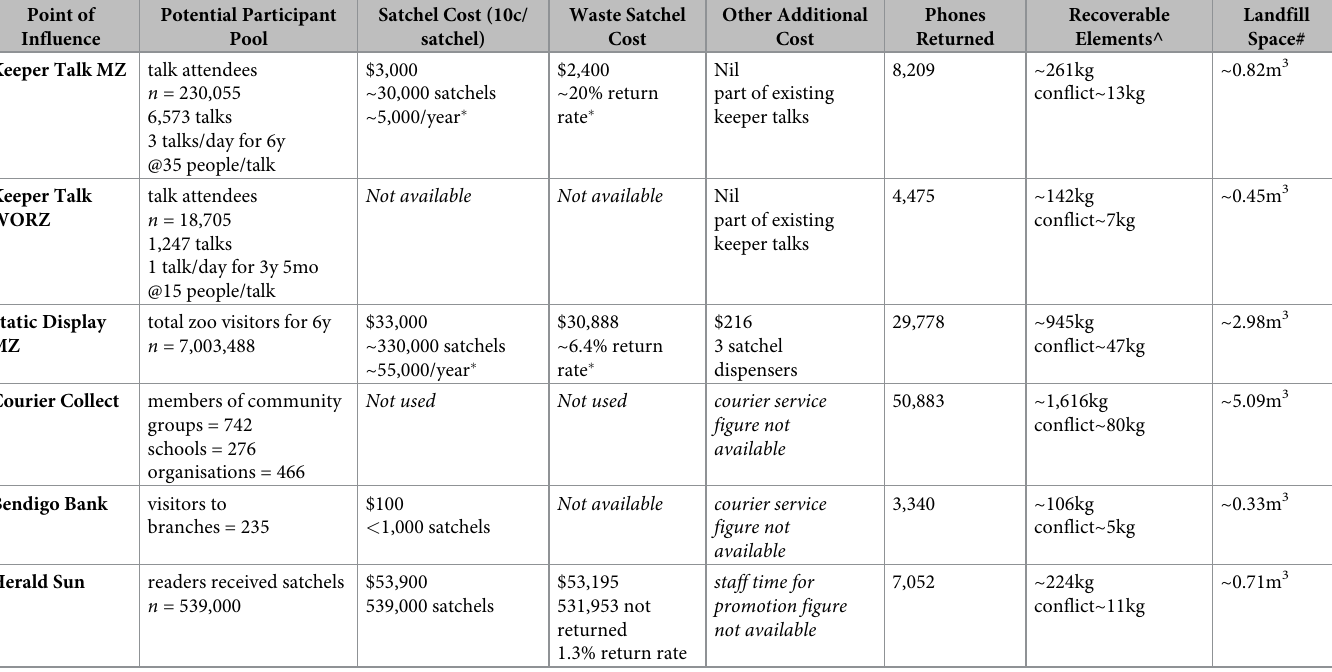
Table 1. For each point of influence (POI), potential participants, costs, phones returned, and estimated recoverable elements and landfill